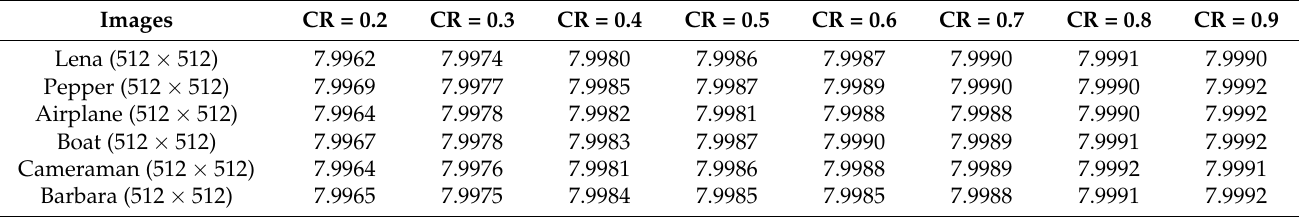
Table 7. Global Information entropy.